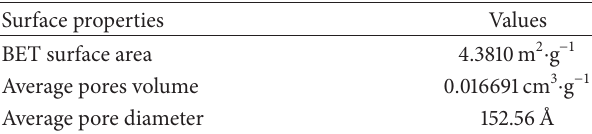
Table 2: Surface properties of C. polygonoides ash. Surface